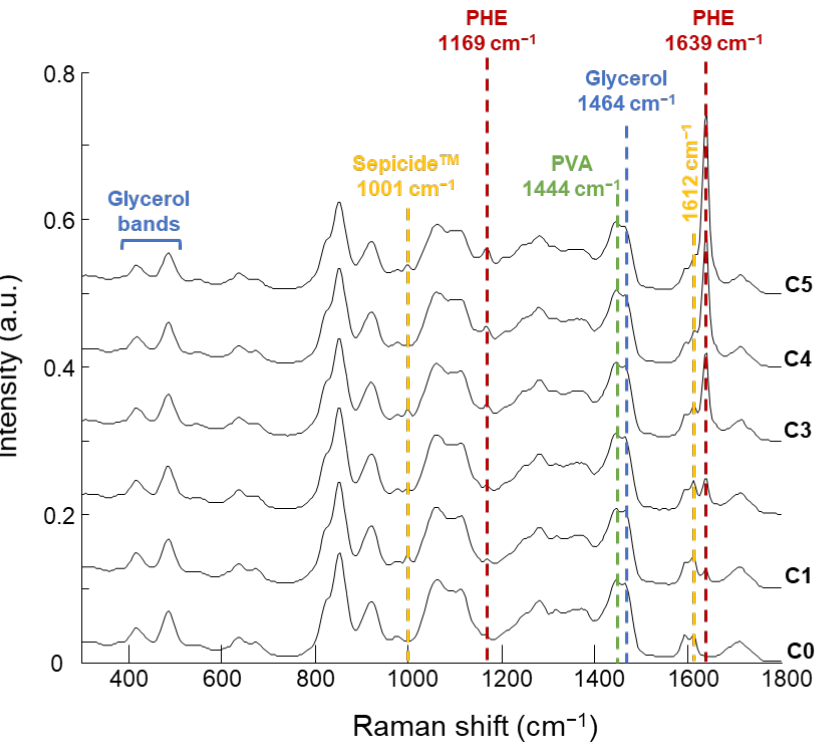
Figure 5. Mean Raman spectra of PVA-GS films loaded with increasing concentration (from C0 to C5) of NanoPHE. Spectra offset for clarity. Dotted line highlights most relevant features of PVA (green), Glycerol (blue), AMA (yellow), and PHE (red).